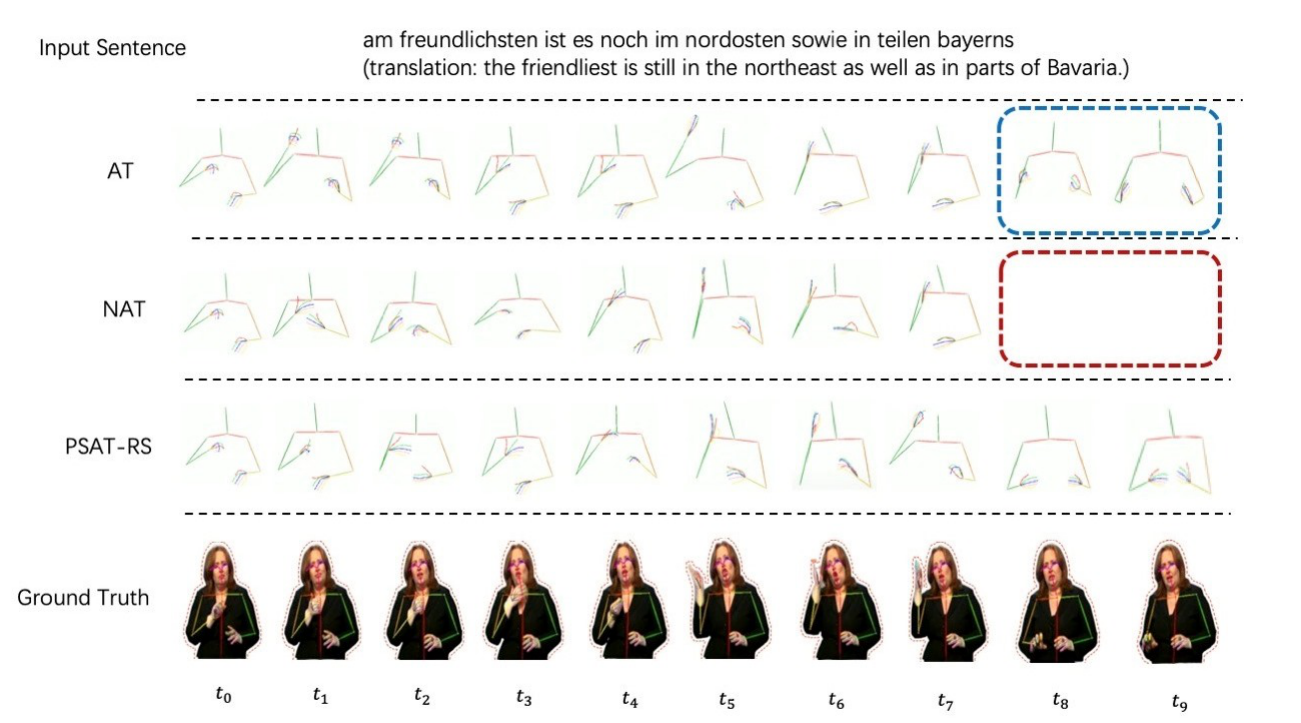
Figure 6. Qualitative results on RWTH-PHOENIX-Weather 2014 T dataset. We uniformly selected 10 frames for each